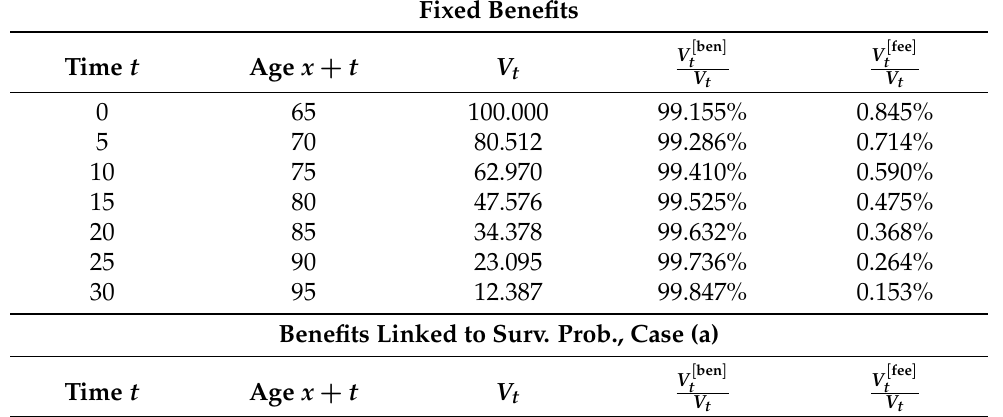
[ ben ] , V [fee] , at selected times t . Moderate aggre- t t